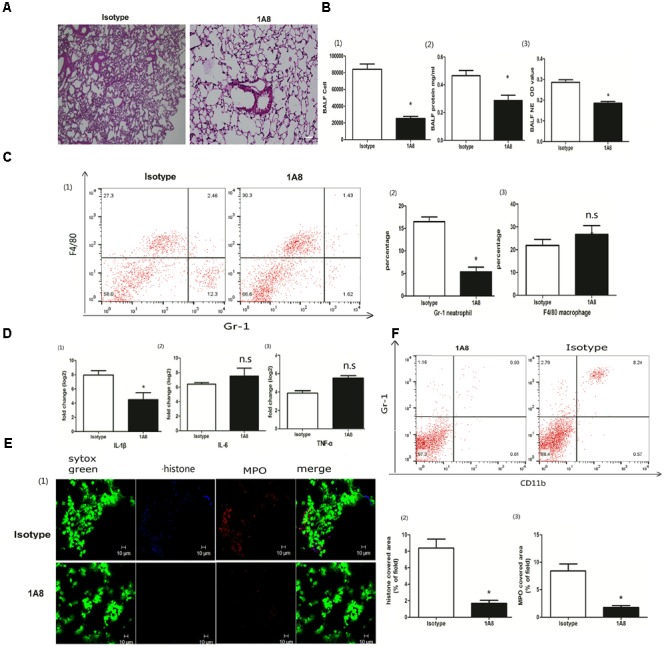
Neutrophil depletion reduced NETs and ALI. (A) Infiltration of inflammatory cells and interstitial edema in the lung lobe were reduced in the ALI model mice with neutrophil depletion, bar = 100 μm; (B-1) cells were counted in the BALF, ∗p < 0.05; (B-2) protein concentration in the BALF, ∗p < 0.05; (B-3) neutrophil elastase (NE) activity was evaluated in the BALF, ∗p < 0.05; (C) flow cytometry analysis of the BALF cells, ∗p < 0.05; (D) inflammatory cytokines IL-1β, IL-6, and TNF-α in the lung were quantified using qRT-PCR, ∗p < 0.05; (E) NETs were observed and quantified in lung tissues from mice administered poly I:C and 1A8 antibody. (F) Effects of 1A8 on neutrophil depletion were validated by flow cytometry.